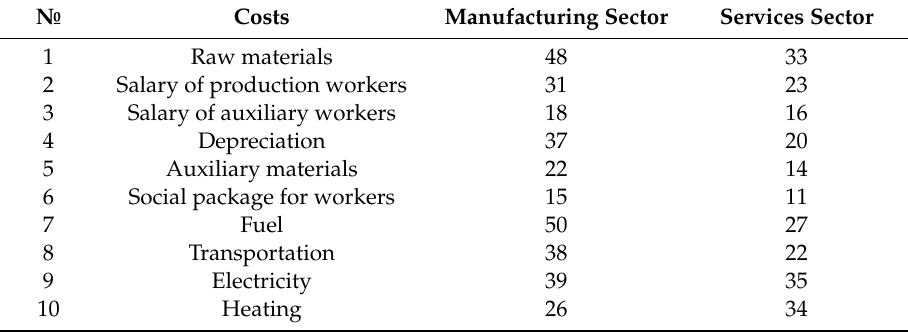
Table 1. The share of organizations with a growth in production costs of more than